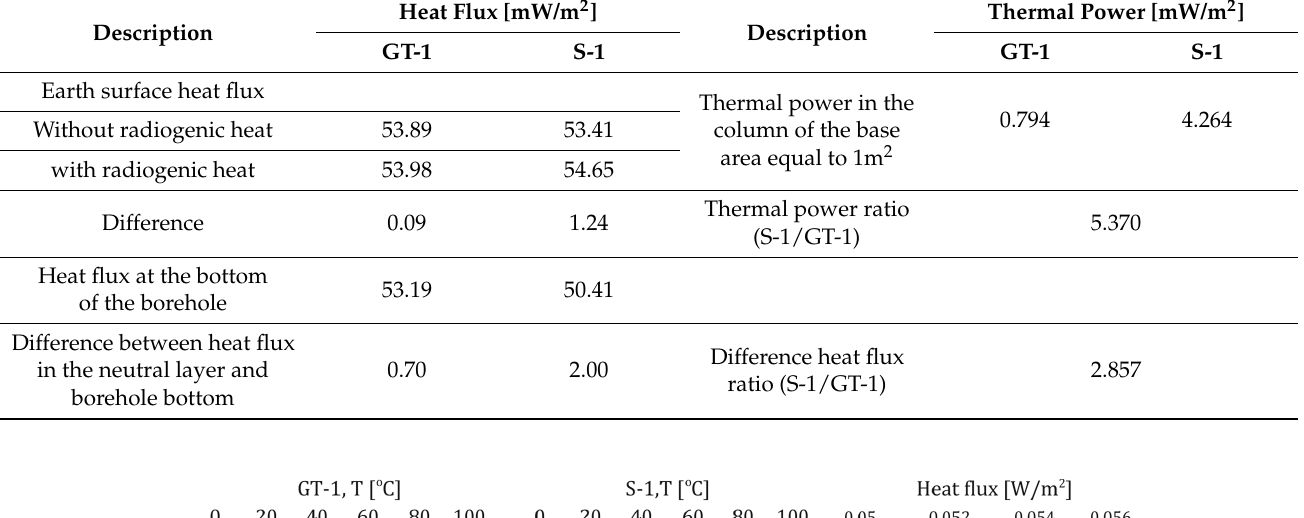
Table 7. Comparison of the heat flow modelling results in GT-1 and S-1 boreholes.